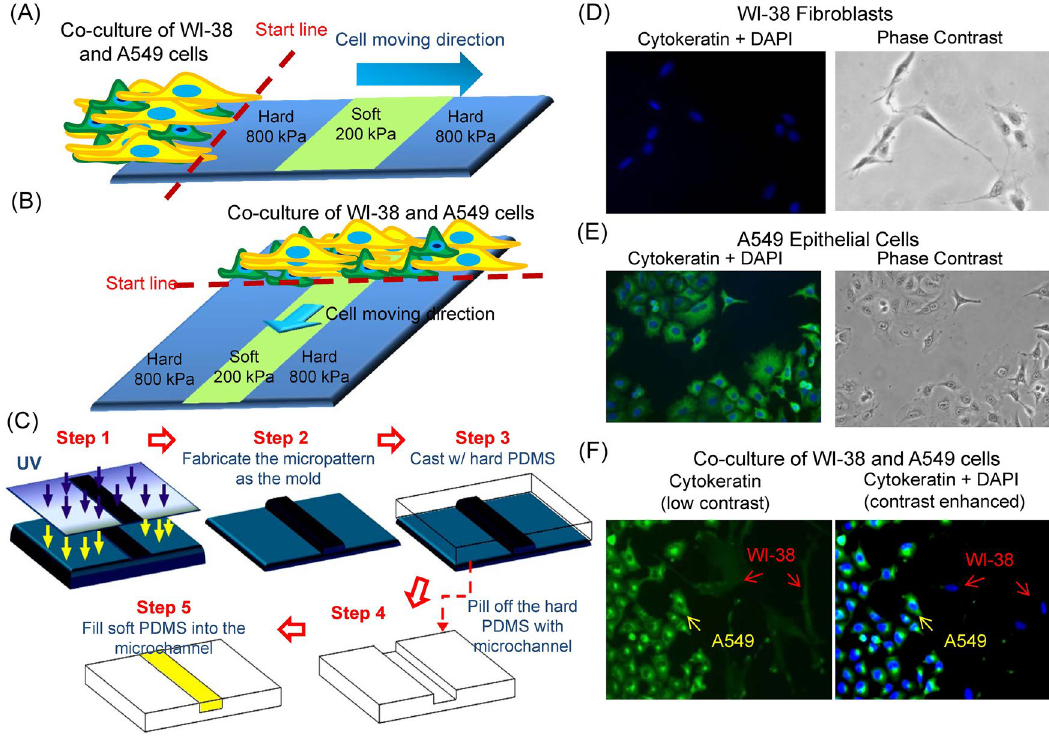
Figure 1. Probing coordinated co-culture tumor cell related motility through differential micro- compartmentalized elastic substrates. ( A , B ) Schematics of our hard–soft–hard (HSH) substrate to probe the effects of localized stiffnesses on cell motility for co-cultures. The soft region is depicted in green and the hard region in blue. ( A ) For the horizontal configuration, the cells were released from the side of the system